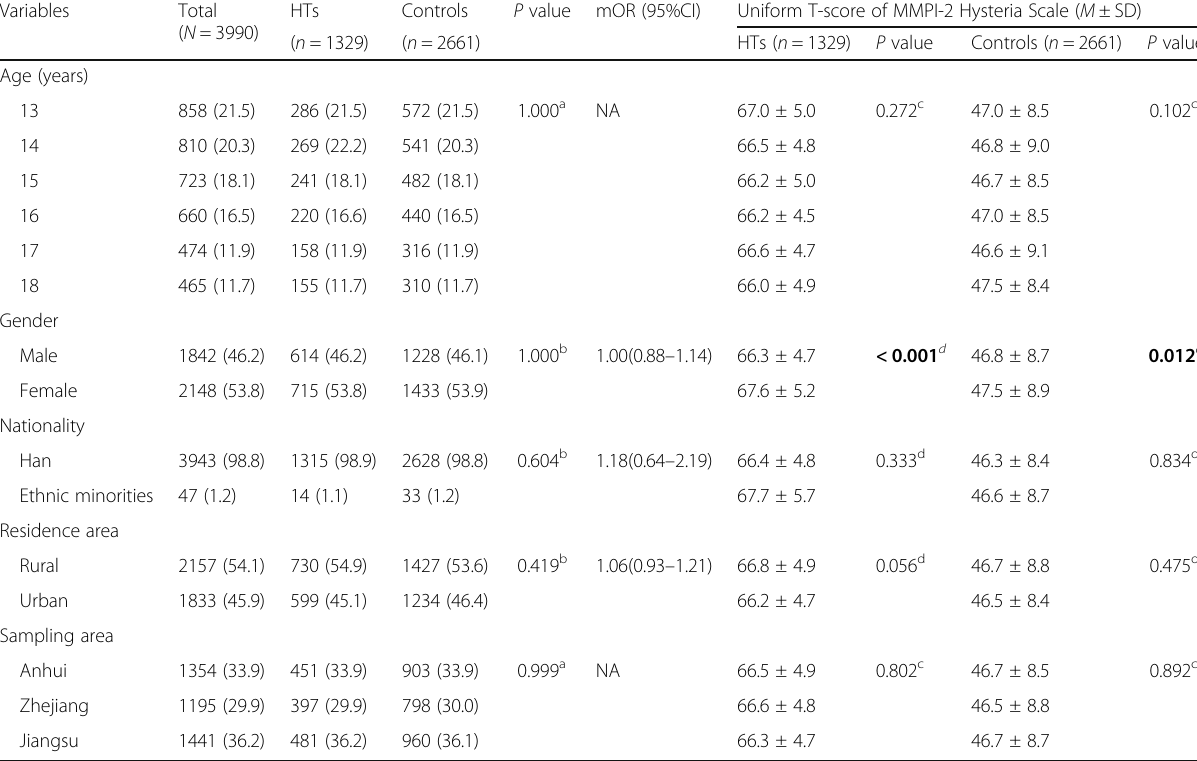
Table 1 Baseline characteristics of all subjects in the multi-center case-control study